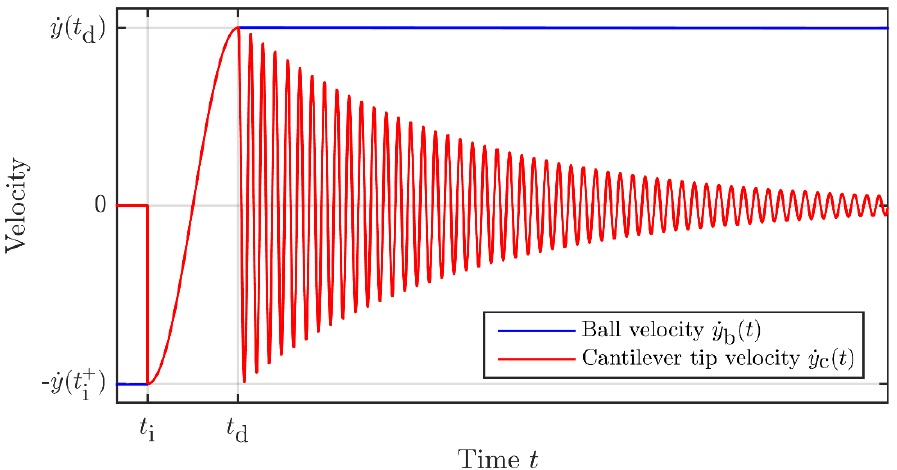
. (t) (blue curve), and of the cantilever tip, ( t ) (blue curve), and of the cantilever tip, y b b